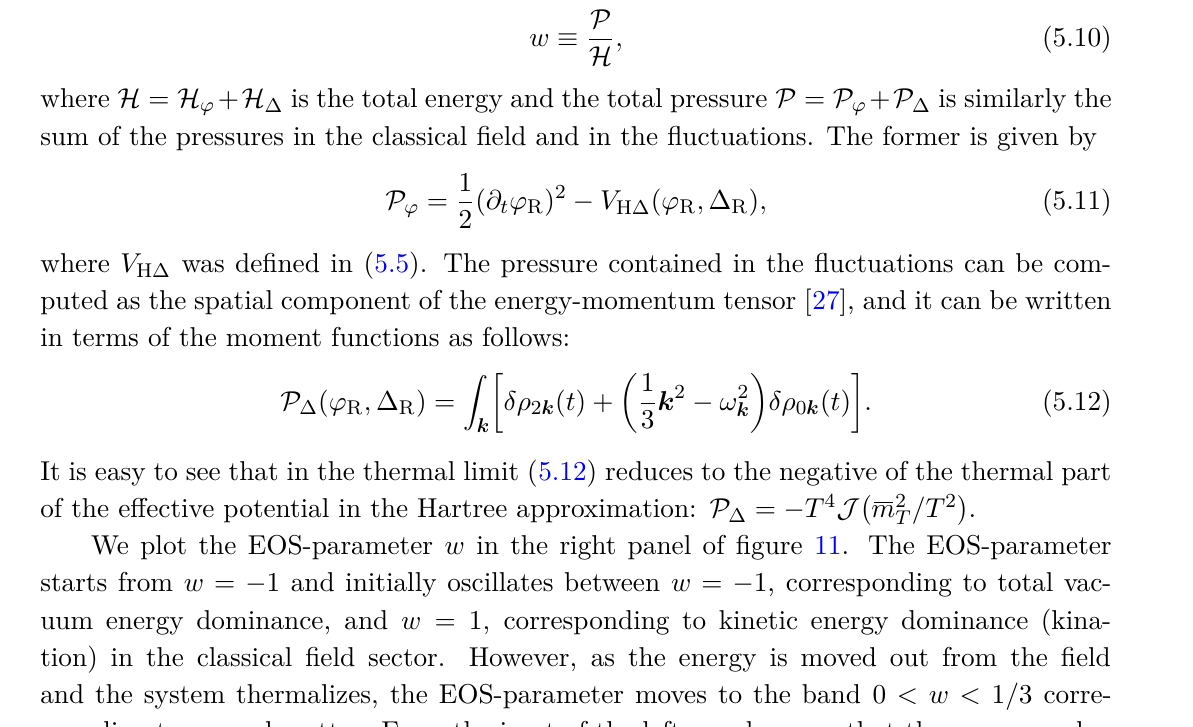
Figure 11 . In the left panel we show the equivalent temperature defined through equation (5.8) as a function of time. The inset shows the parameter x eff ≡ sgn we show the EOS-parameter of the system defined in equation (5.10). The black arrows indicate the limiting cases of vacuum ( w = − 1 ) and kinetic ( w = 1 ) energy dominance as well as matter ( w = 0 ) and radiation ( w = 1 / 3 ) EOS’s, shown by horizontal lines. In all graphs shown the red arrow points the region of maximal spinodal